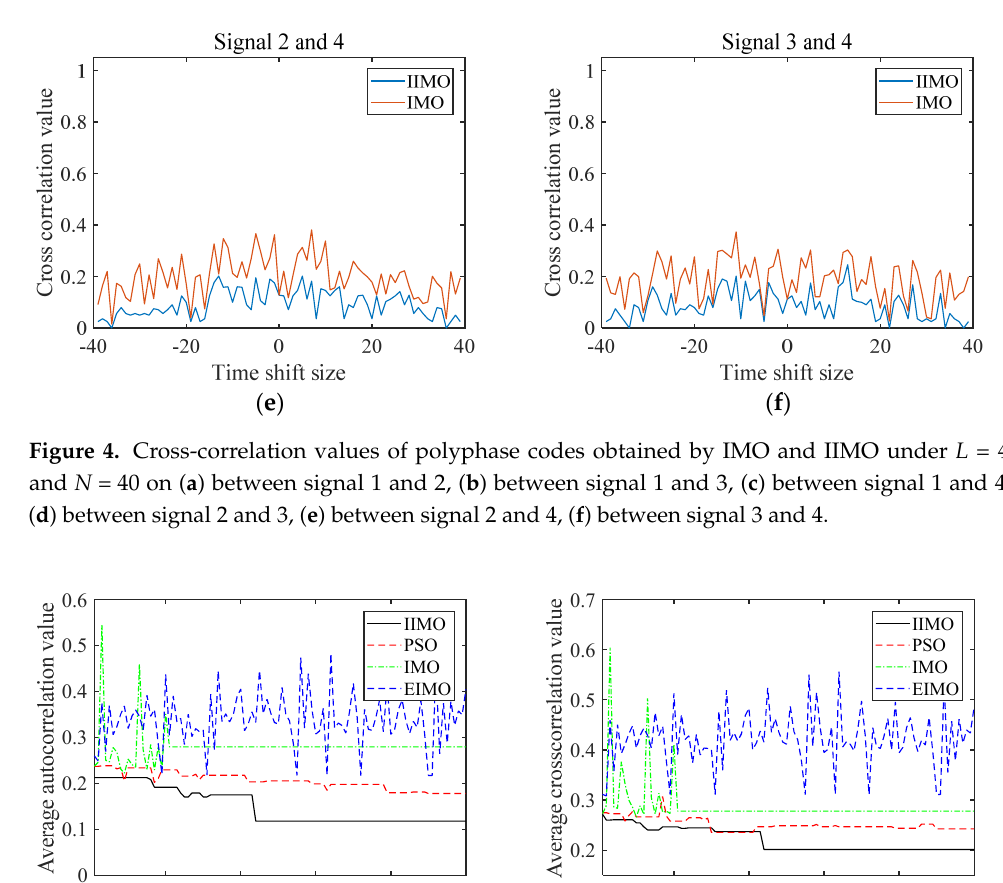
Figure 4. Cross-correlation values of polyphase codes obtained by IMO and IIMO under L = 4 and N = 40 on ( a ) between signal 1 and 2, ( b ) between signal 1 and 3, ( c ) between signal 1 and 4, ( d )